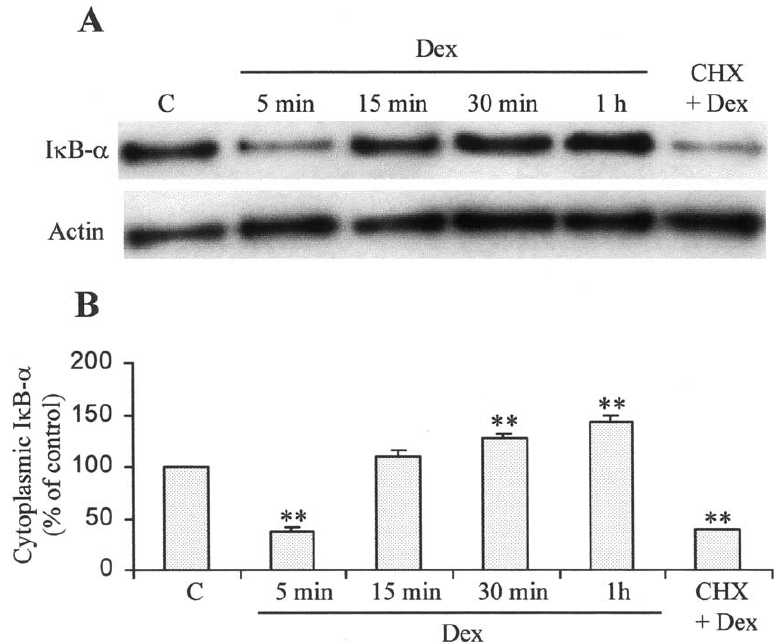
FIG. 1. Dex induces the degradation followed by the re-synthesis of the cytoplasmic protein I k B- a . CCRF-CEM cells were treated with Dex (1 m M), for the indicated periods, in the absence or in the presence of CHX (20 m g/ml) for 1 h. The cytoplasmic extracts were prepared as described in Materials and methods. The cytoplasmic I k B- a content was determined by western blot analysis, using a rabbit polyclonal anti-I k B- a antibody (A), and the bands were quantified with an image analyser (B). The results presented in the upper panel (A) are representative of three independent experiments. The data shown in the lower panel (B) are the average 9 / SD of three independent experiments. ** p B / 0.01, as determined by one-way analysis of variance with Dunnett’s post